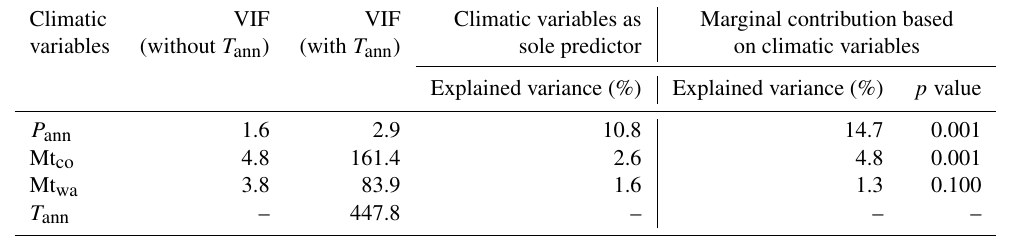
Table 2. Summary statistics of redundancy analysis (RDA) of 19 pollen species and four climatic variables. VIF: variance inflation factor; P ann : mean annual precipitation (mm); Mt co : mean temperature of the coldest month ( ◦ C); Mt wa : mean temperature of the warmest month ( ◦ C); and T ann : annual mean temperature ( ◦ C).